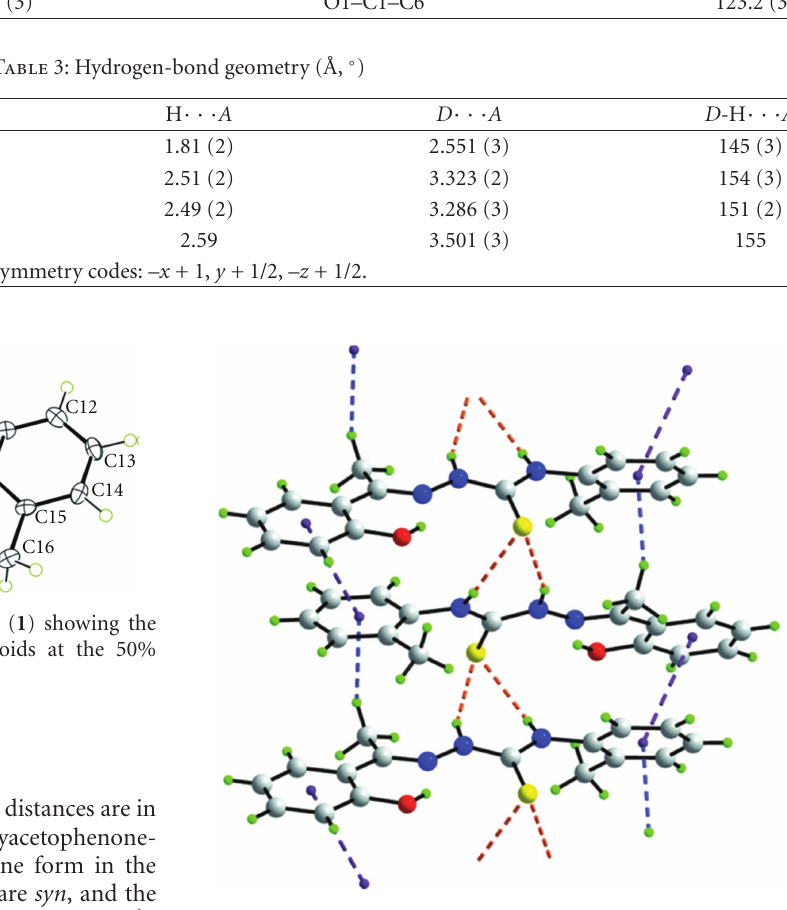
Figure 2: A view of the helical supramolecular chain aligned along the b axis in (I). The N–H ··· S hydrogen bonds are shown as orange dashed lines. Further stabilization to the chain is provided by C– H ··· π and π – π interactions, shown as blue and purple dashed lines,